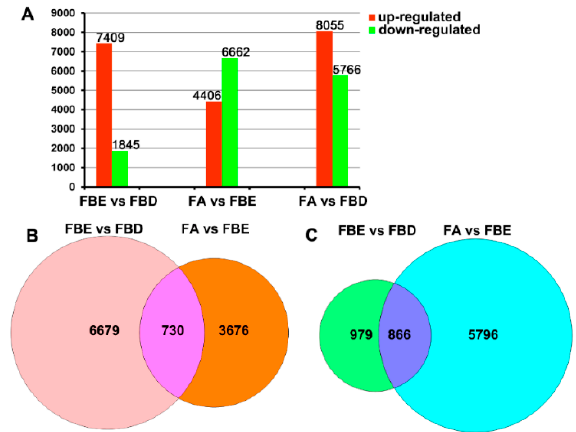
Figure 2. Numbers of differentially expressed genes (DEGs) involved in phase changes during flower development of flower bud differentiation (FBD), floral bud elongation (FBE) and floral anthesis (FA). ( A ) The numbers of DEGs in FBE vs. FBD, FA vs. FBE and FA vs. FBD. ( B ) The numbers of upregulated DEGs in FBE vs. FBD and FA vs. FBE. ( C ) The numbers of downregulated DEGs in FBE vs. FBD and FA vs. FBE.